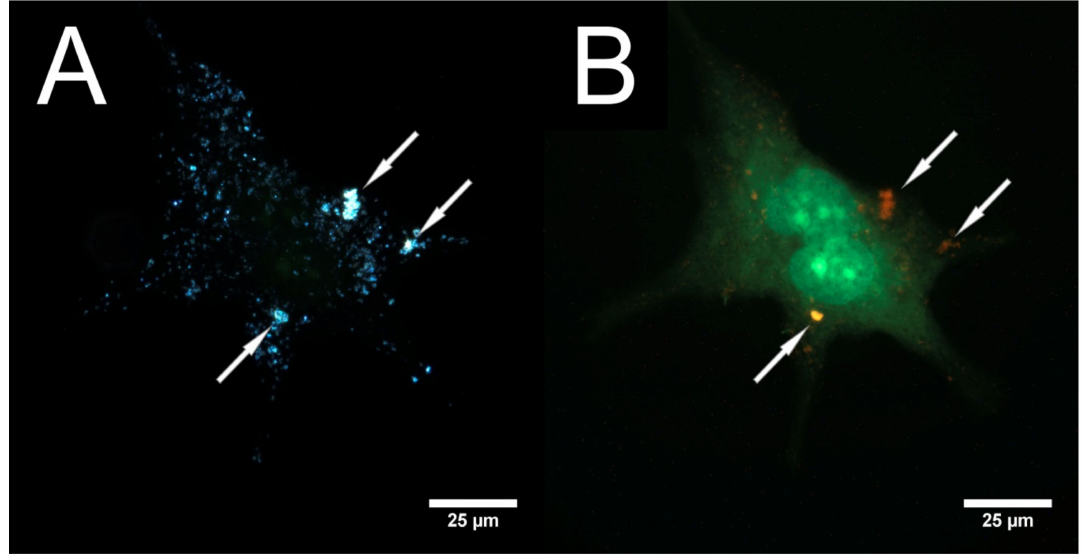
Figure 4. Visualization of PC-3 cell labeled with HNT-NH 2 -CdS: dark-field microscopy image of PC-3 with HNT-NH 2 -CdS ( A ) and fluorescence image of cells stained with ReadyProbes ® Cell Viability Imaging Kit (Blue/Green) (ThermoFisher) ( B ). HNT-NH 2 -CdS appeared as bright white spots (A, marked by arrows), or yellow and red spots (B), (marked by